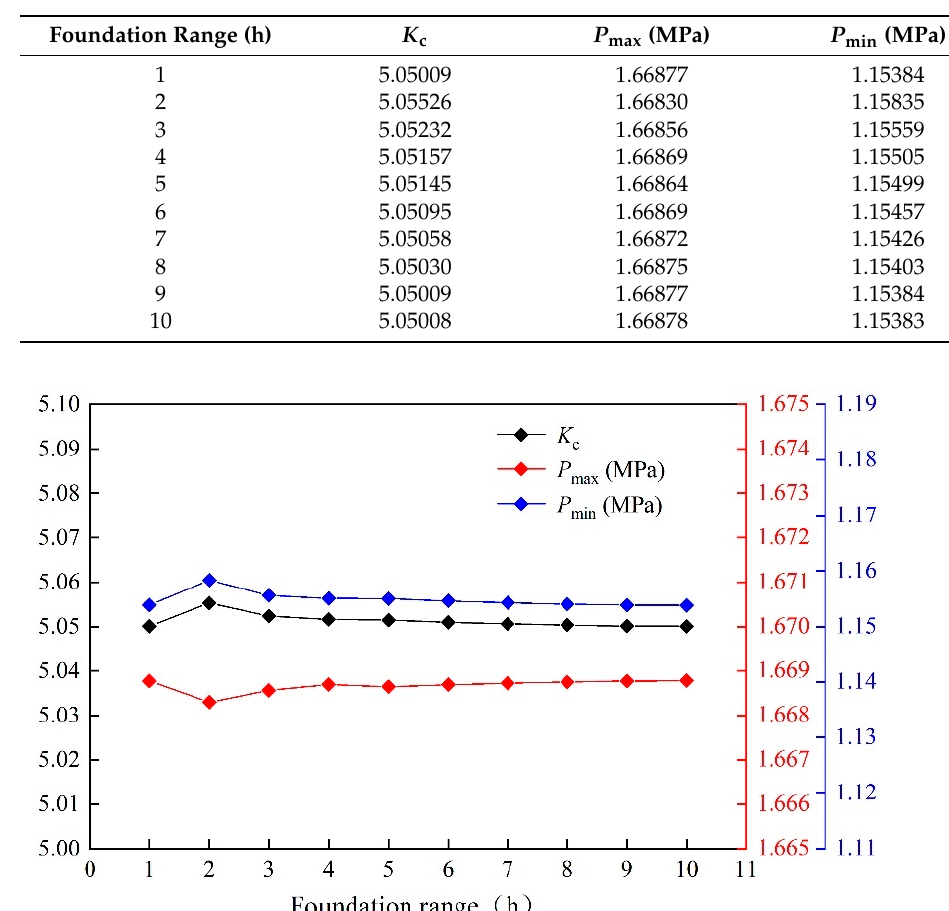
Figure 4. The influence of the foundation range change on the calculation results.